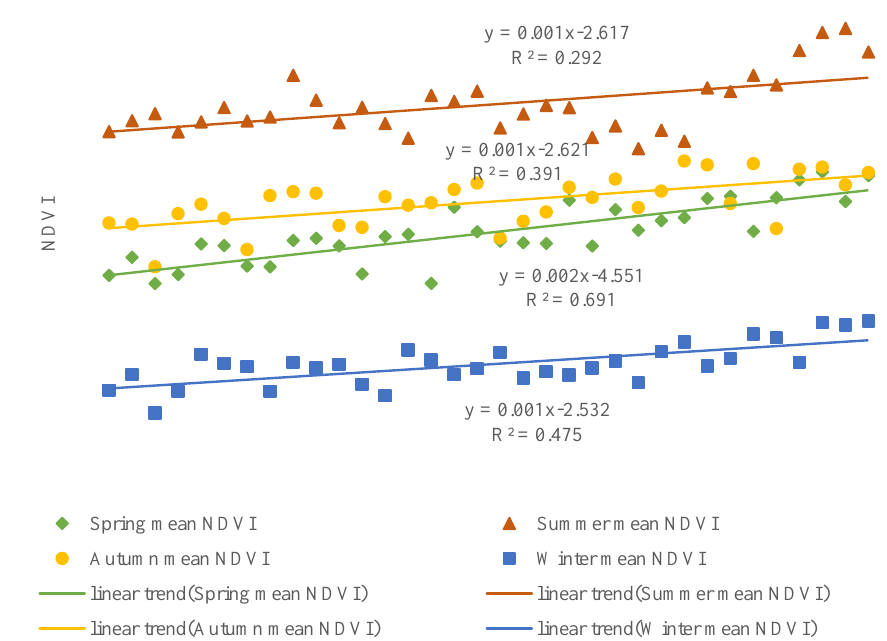
Figure 4. Inter-annual variations of seasonal mean NDVI in Shaanxi Province during 1982–2015 (Spring (March–May), Summer (June–August), Autumn (September–November), Winter (December, January, February). The x -axis represents the year.).